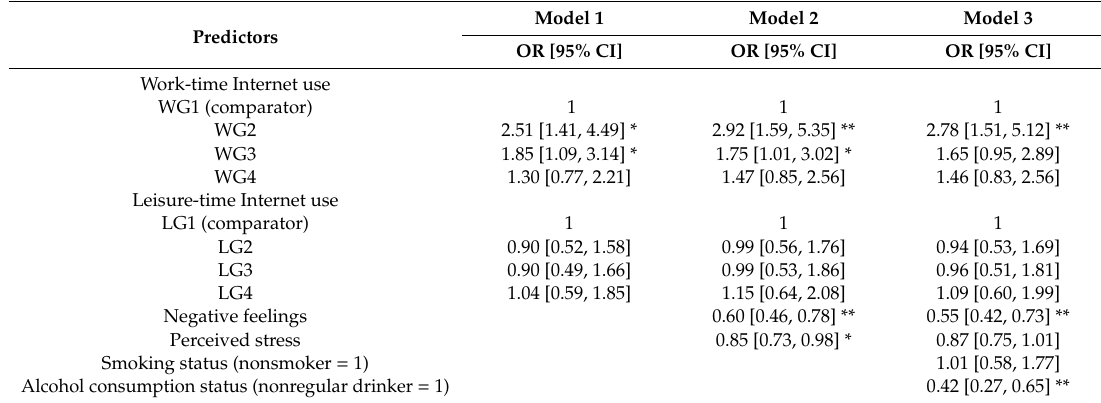
Table 4. Regression models predicting perceived quality of life.